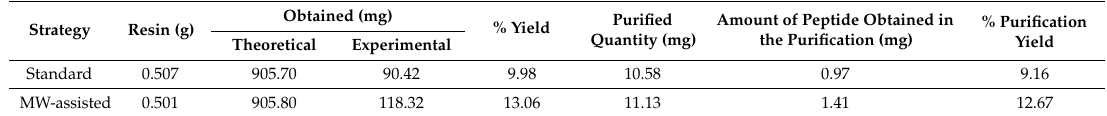
Table 2. Control synthesis of standard and MW-assisted strategies.